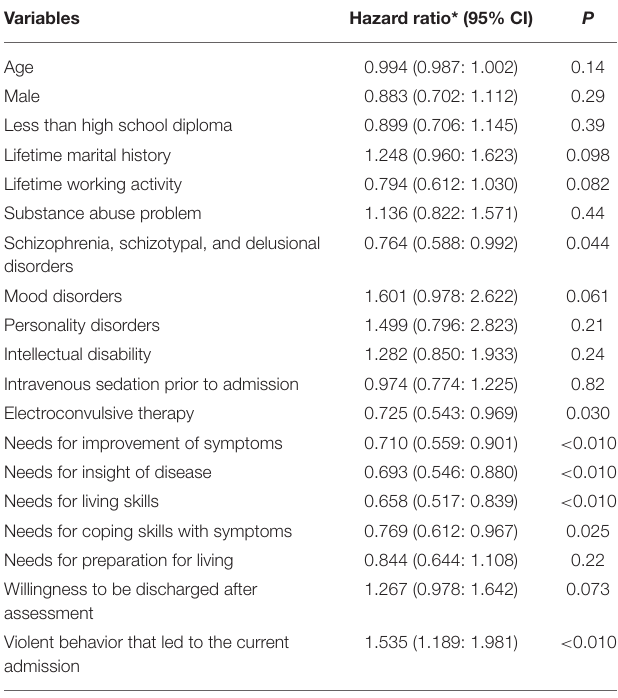
TABLE 2 | Cox proportional univariate hazard ratios.